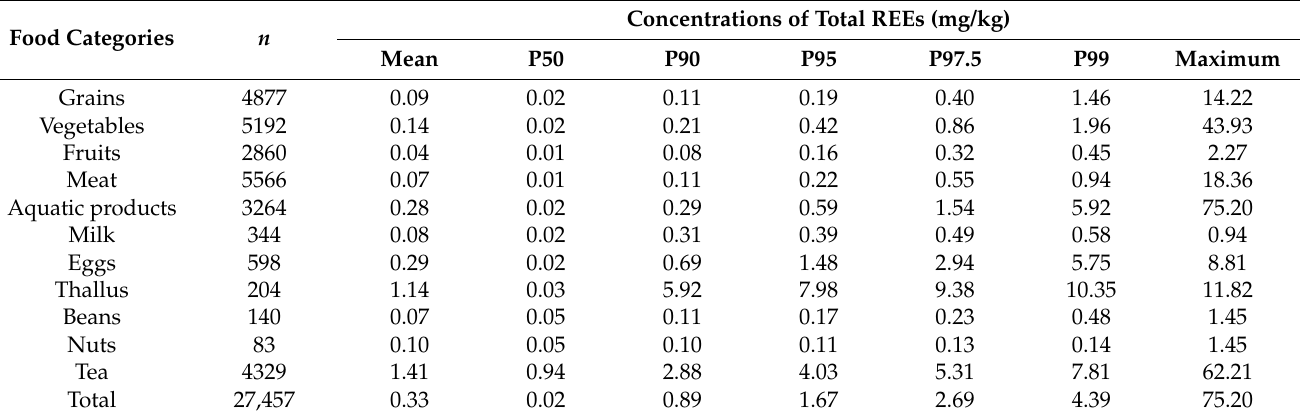
Table 1. Concentrations of the total REEs in different food